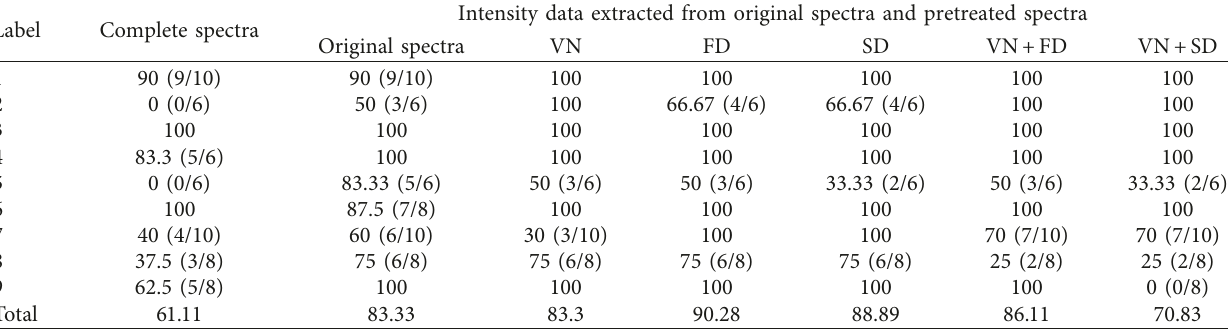
Table 4: The correction rates of cluster analysis based on complete spectra and intensity data extracted from original spectra and pretreated spectra (%).